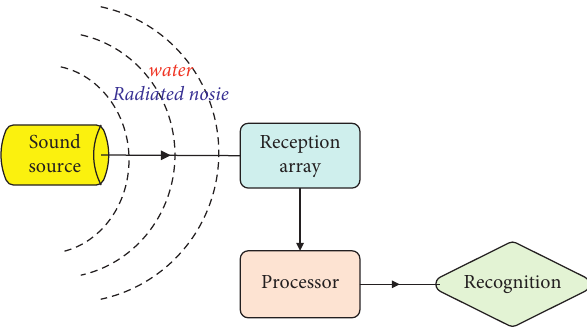
Figure 1: Information flow of the passive